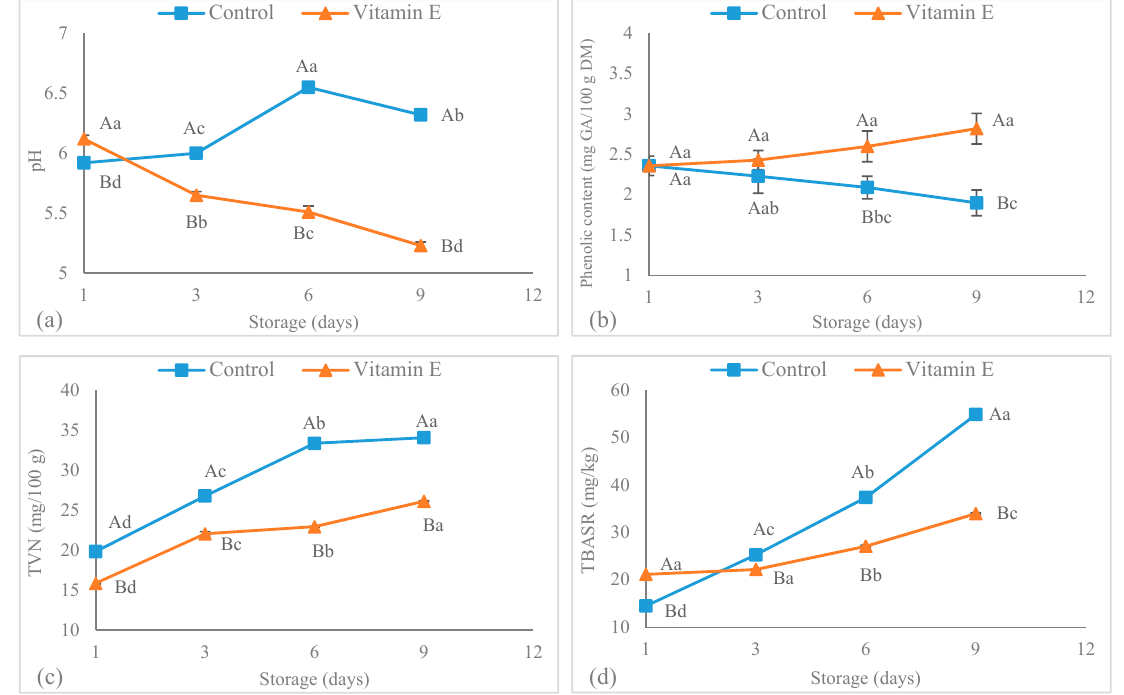
Figure 1. Changes in pH ( a ), phenolic content ( b ), thiobarbituric acid reactive substances = TBARS index ( c ) and total volatile base nitrogen = TVN ( d ) of goose meat supplemented with vitamin E at 4 ◦ C during storage. a–d Quality values level within treatment during storage with di ff erent letters di ff er significantly ( p < 0.05); A–B Quality values level between treatments with di ff erent letters di ff er significantly ( p <